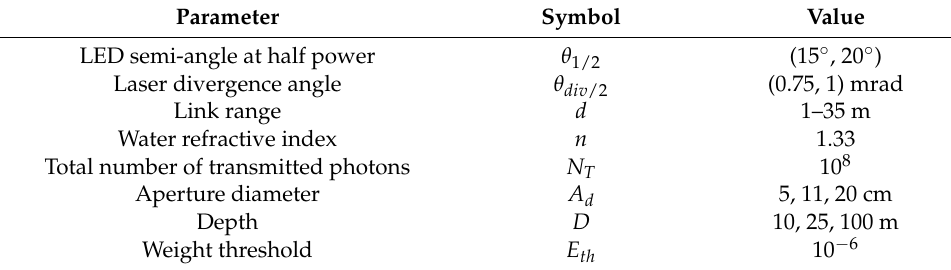
Table 3. UOWC system